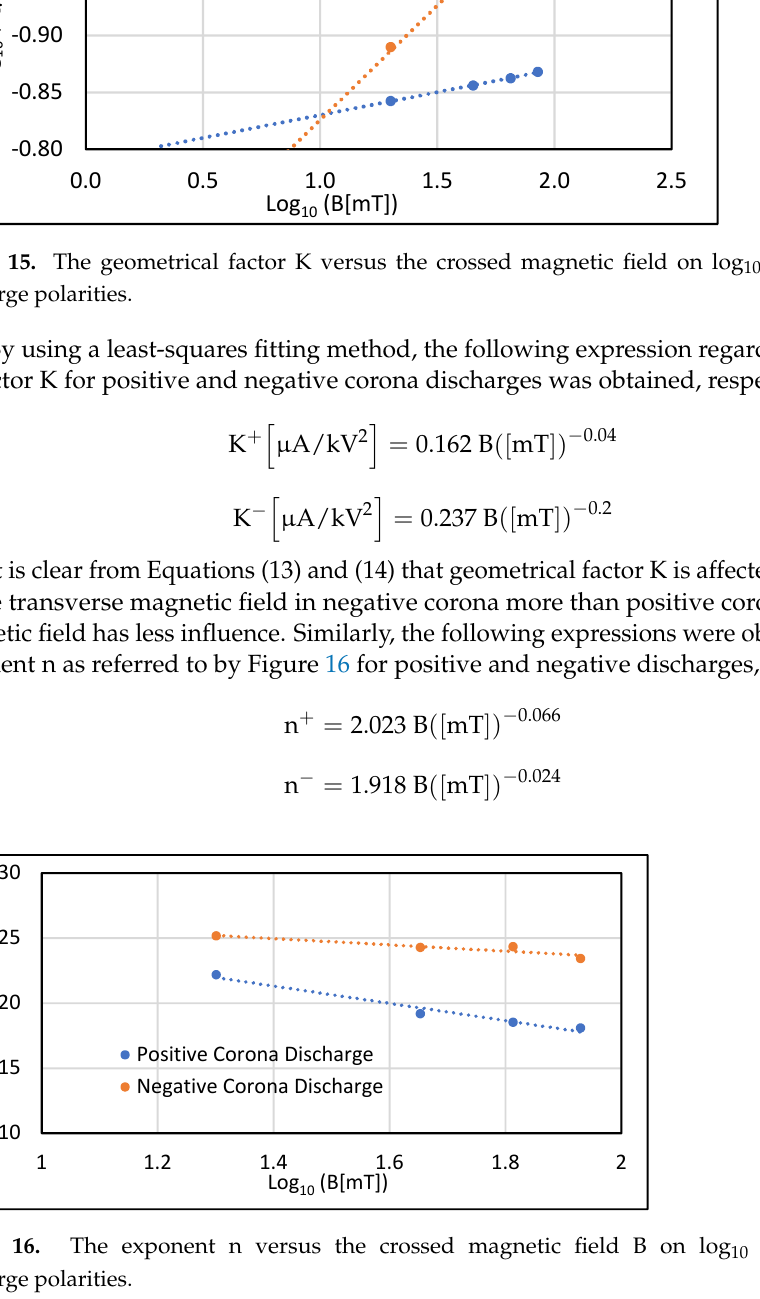
10 scale for both dis-